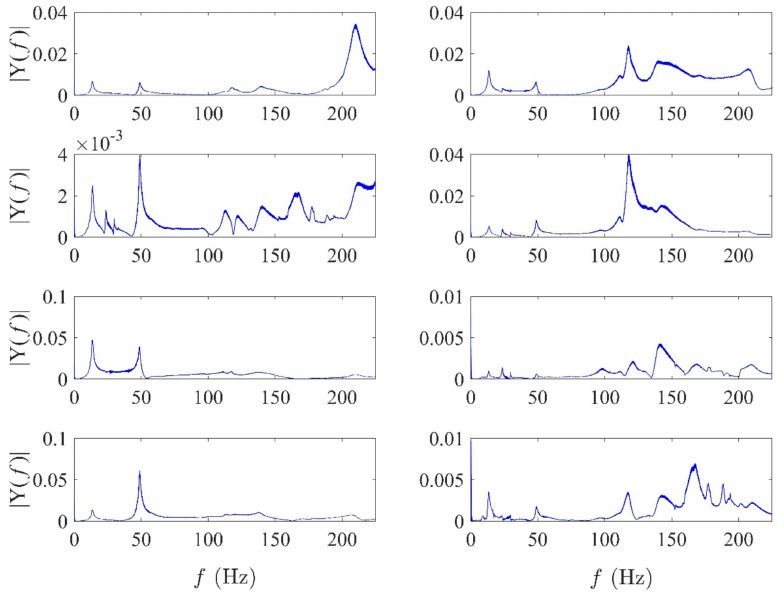
Figure 12. Fourier spectra of SOBI results applied on the C+25 test conducted on the wind turbine